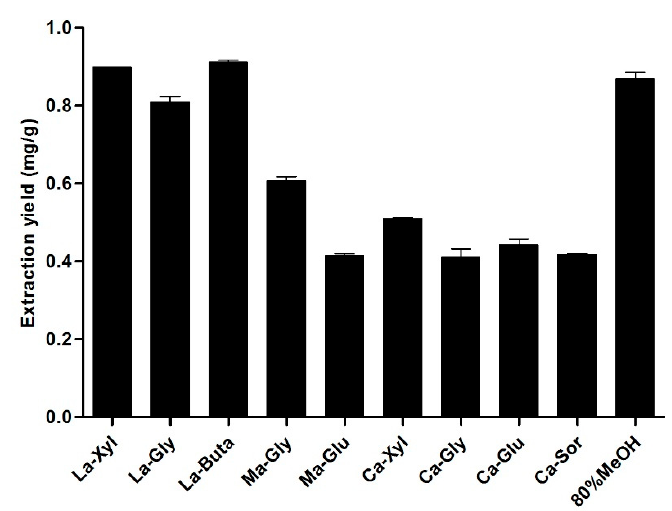
Figure 5. Rutaecarpine extraction yields of 75% organic acid-based DESs solutions and reference solvent 80% aqueous methanol ( v / v ) for comparison. Varied DES aqueous solution was used as solvent to extract at a solid-liquid ratio of 1:50 with ultrasound at 35 °C and 500 W for 40 min. Data represent mean ± S.D. of triplicated experiments.